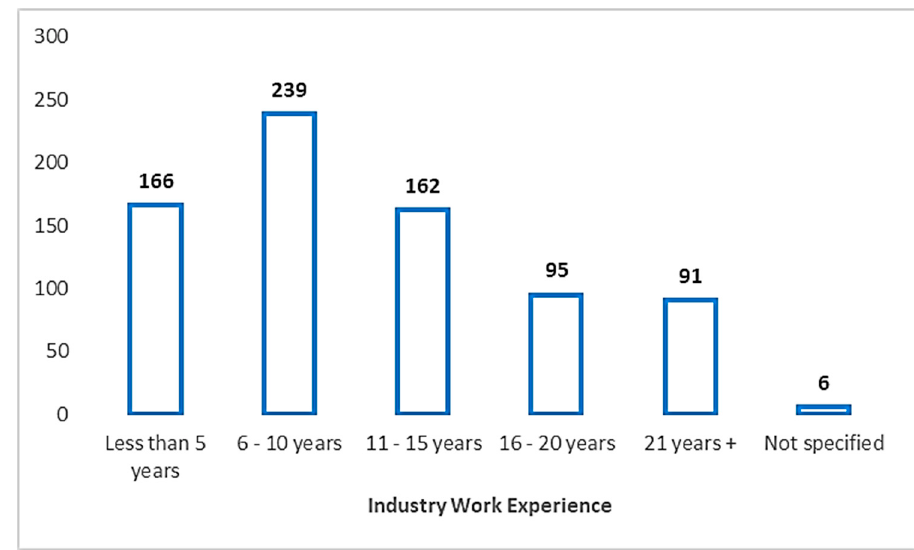
Figure 2. Highest academic qualification of construction stakeholders.